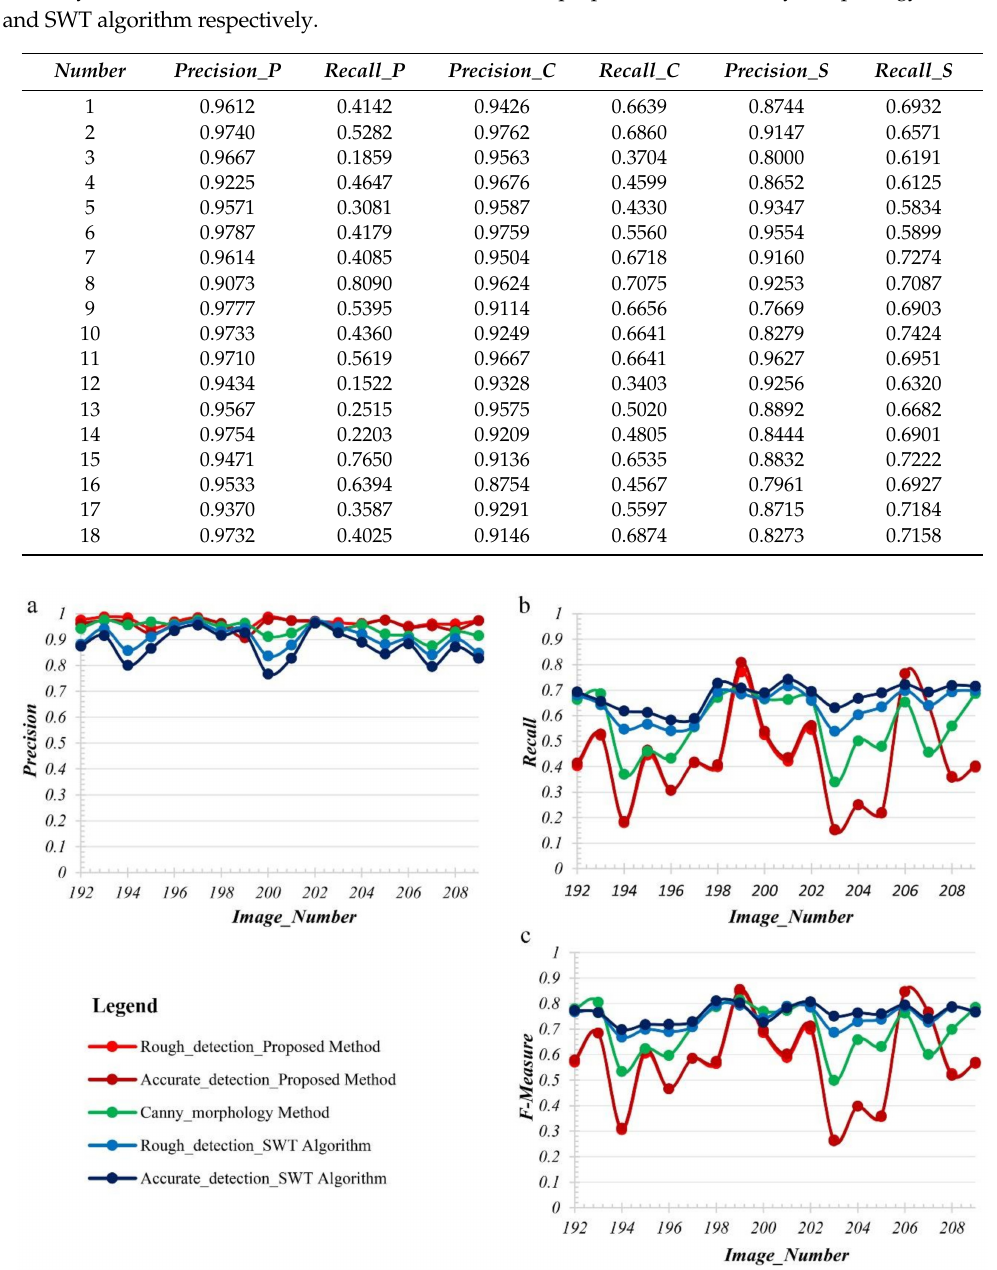
Figure 11. Detection accuracy for expansion joints of all images. And ( a ) is the Precision curves using the proposed method, the canny_morphology method, and the SWT Algorithm. ( b ) is the Recall curves using the proposed method, the canny_morphology method, and the SWT Algorithm. ( c ) is the F-measure curves of using the proposed method, the canny_morphology method, and the SWT